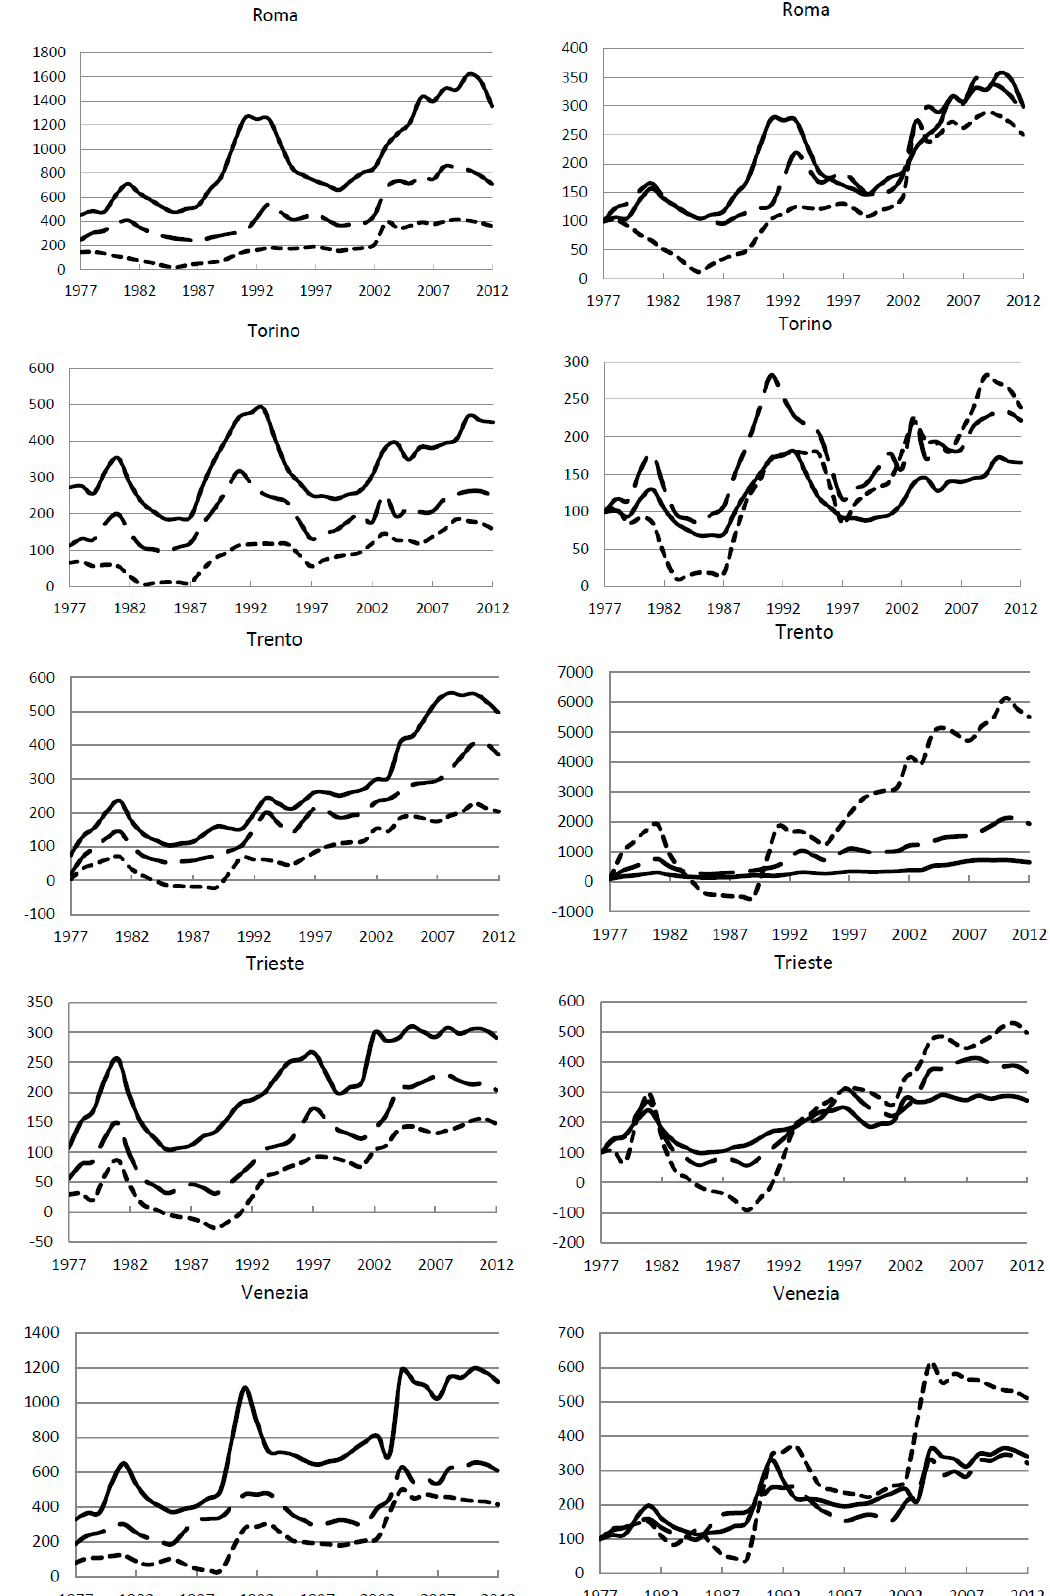
Figure A1. The trend of values of urban land from 1977 to 2012 in the regional Italian capital cities and for different urban areas.